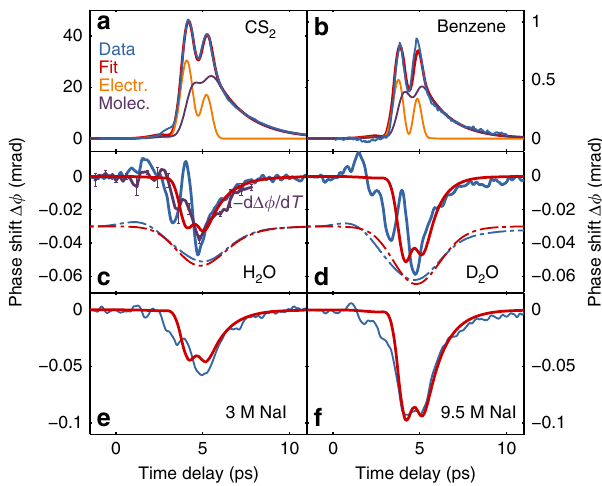
Fig. 1 The THz-induced Kerr effect in water and reference liquids. The re fi nement (red curve) is the sum of two contributions: An instantaneous electronic birefringence (orange curve) and a delayed, molecular birefringence (purple curve). While in the non-polar molecules carbon disul fi de (CS 2 ) and benzene ( a , b ), a positive molecular alignment effect is observed together with a positive electronic response, the polar water molecules in regular (H 2 O; c ) and heavy (D 2 O; d ) water as well as aqueous solutions of sodium iodide (NaI; e , f ) reveal a negative molecular orientation effect. The electronic Kerr effect background of the cuvette was subtracted. We also isolate the molecular orientation mechanism of water based on its temperature dependence (cid:2) d Δ ϕ = d T (purple curve) in a background-free measurement. Error bars correspond to the standard deviation. In c, d , additional dotted curves, offset by − 0.03 mrad, correspond to a convolution with a Gaussian σ = 1.4 ps. Error bars represent the standard